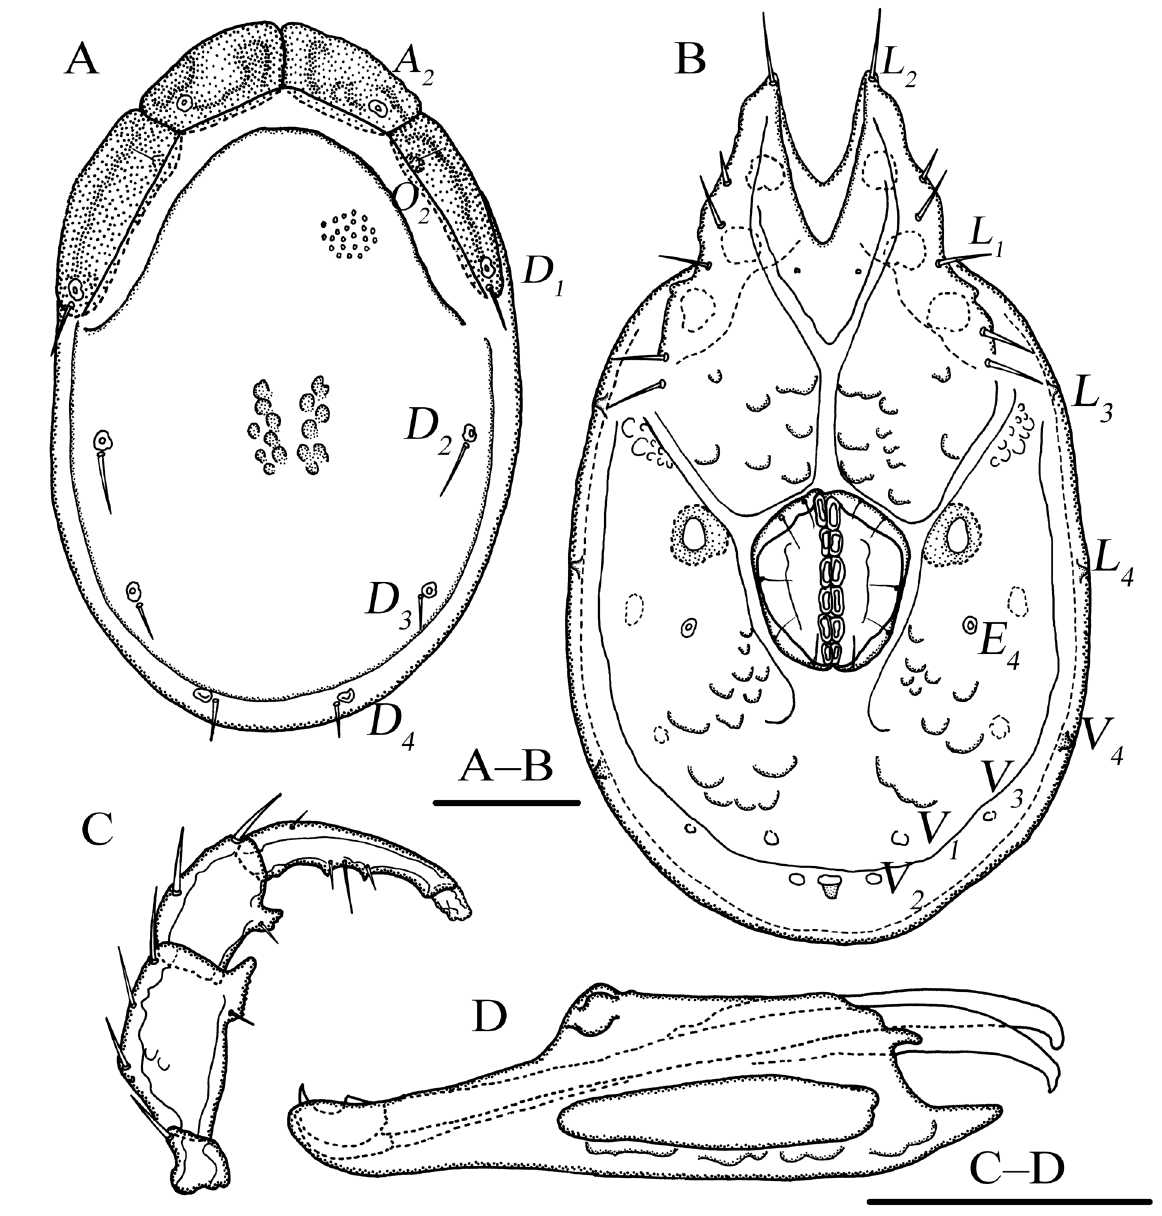
Fig. 15. Torrenticola dentifera Wiles, 1991, ♀, (FJ-TO-20180807). A . Dorsal view. B . Ventral view. C . Palp, lateral view. D . Infracapitulum and chelicera. Scale bars = 100